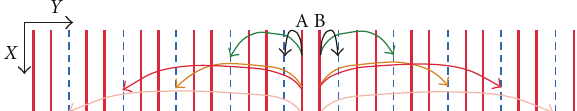
Figure 9: Coulomb transitions from nearest electron pair AB at ν = 2 / 3. (The electric current flows along the x -direction. The momentum value is related to its central position of the y direction as in